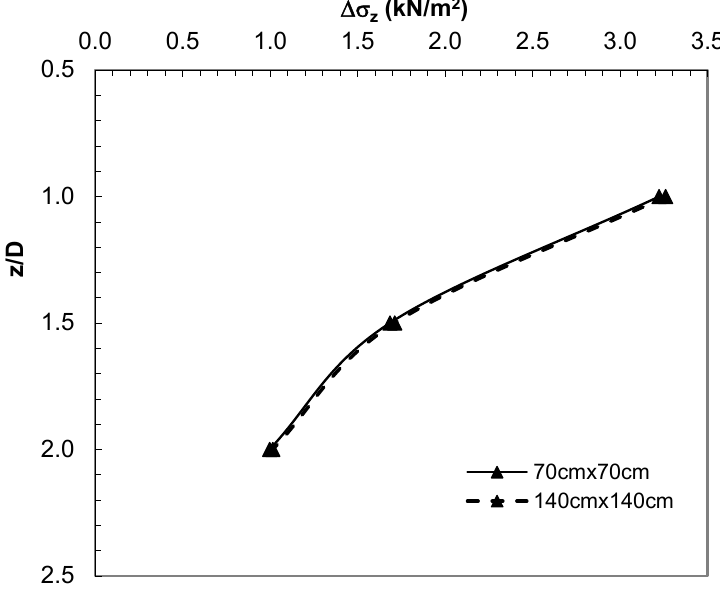
Figure 17. Vertical stress values obtained from analysis of the boundary effect.